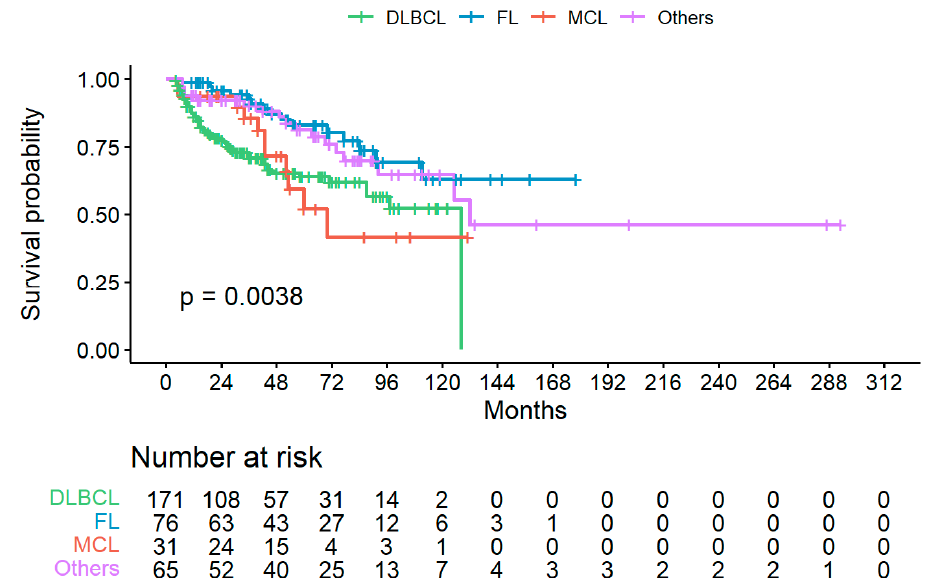
Figure 2. Overall survival (OS) of enrolled patients divided per lymphoma type; landmark analysis is starting from date of diagnosis. Only patients with known status (i.e., alive or death for any cause) at last follow up are reported. DLBCL = diffuse large B cell lymphoma; FL = follicular lymphoma; MCL = mantle cell lymphoma.